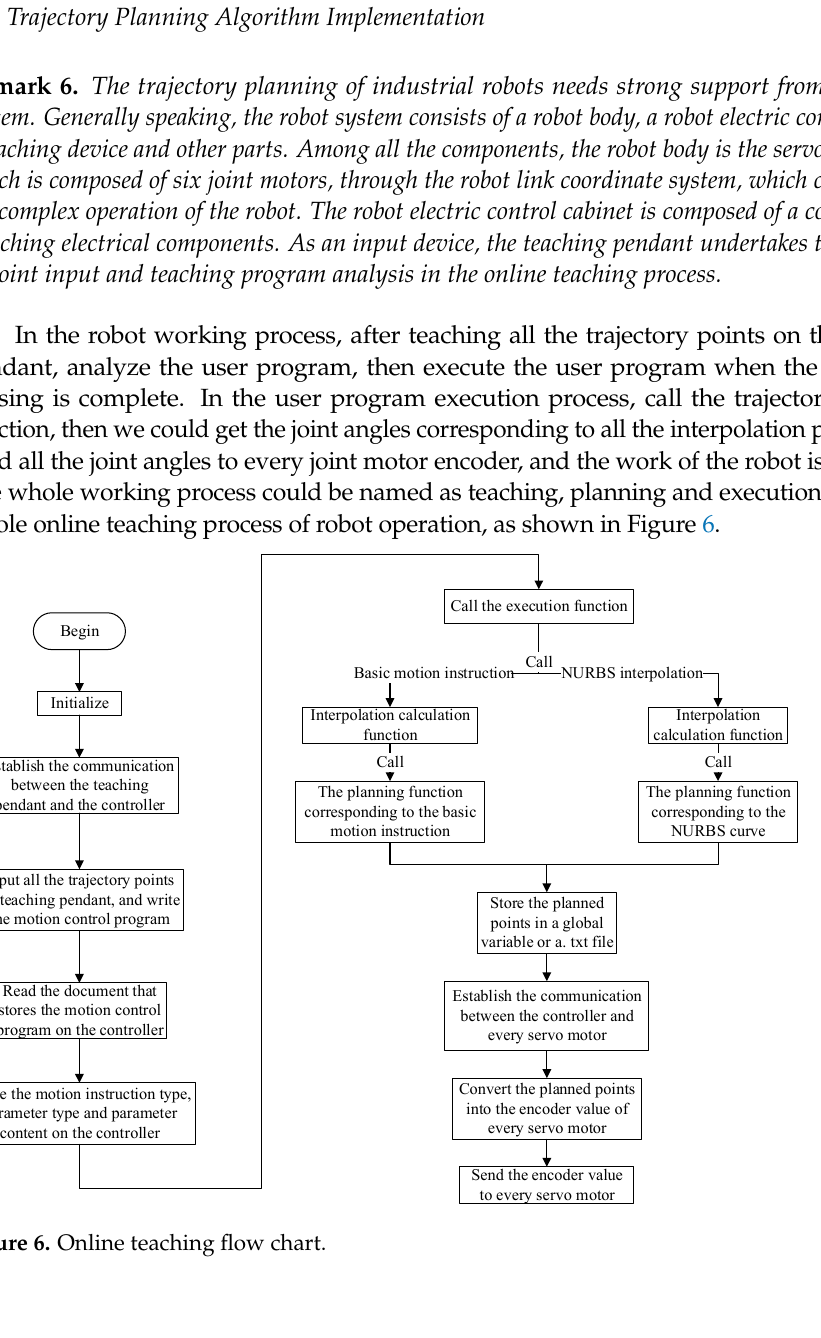
Figure 5. Flow chart of robot’s end-effector trajectory planning.